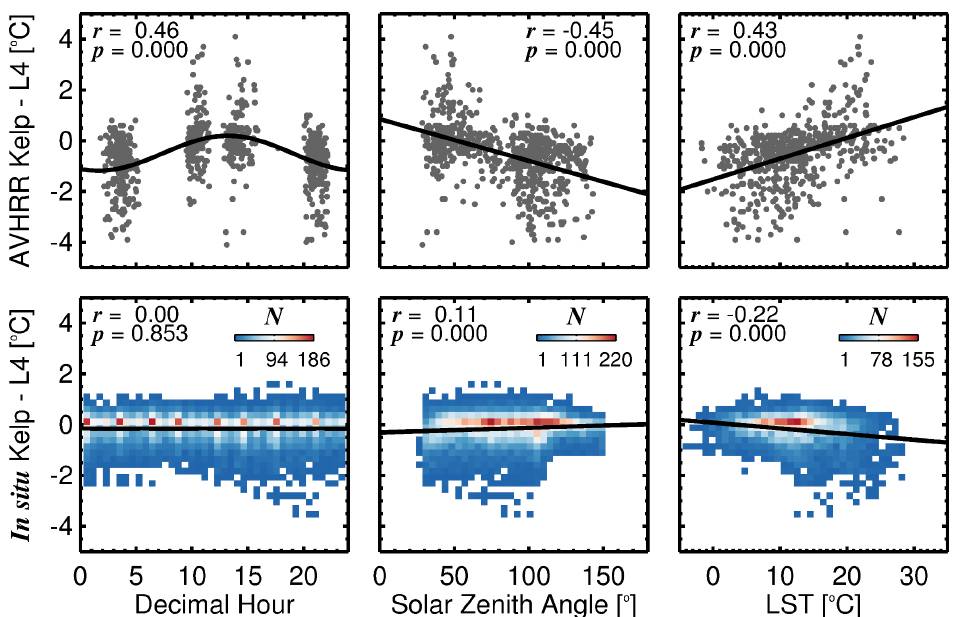
Figure 6. Differences between temperature data at the kelp site and at Station L4, as a function of decimal hour of day, solar zenith angle and Land Surface Temperature (LST), from AVHRR SST N (top row) and for in situ data (bottom row). r is the Pearson correlation coefficient and p is the significance of this correlation.